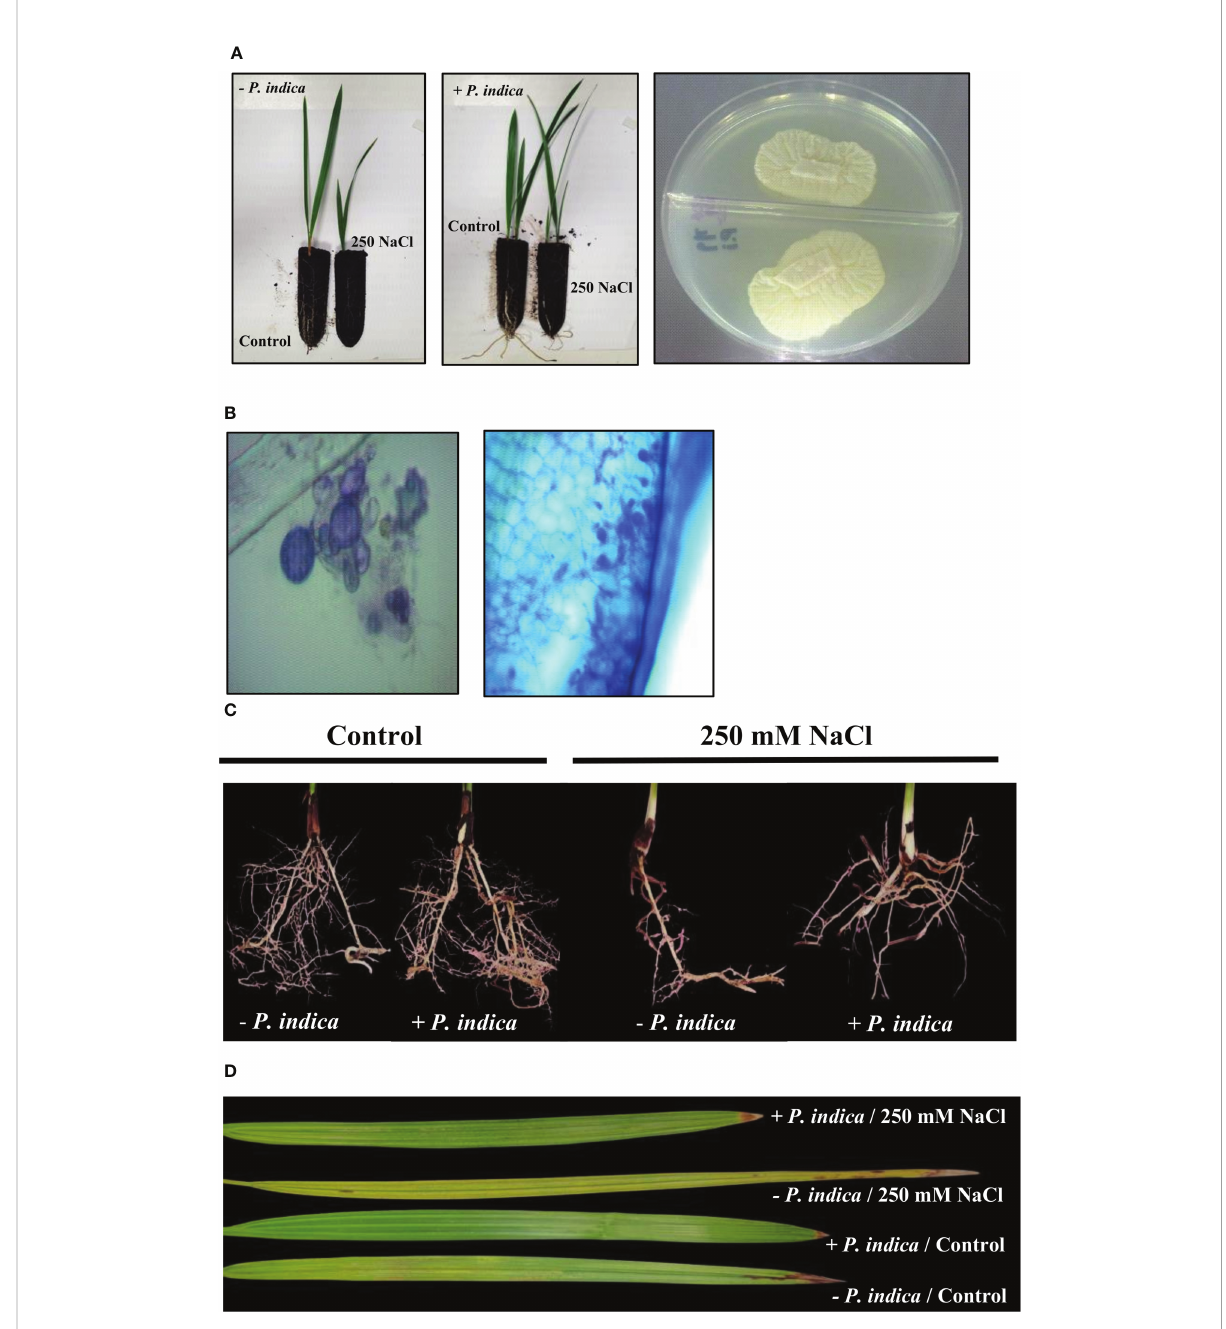
FIGURE 1 P. indica inoculation enhanced date palm seedlings root growth and biomass under control and salt stress conditions. (A) P. indica was axenically grown on PDA medium and used to inoculate date palm roots. (B) The colonized roots were stained and viewed under compound bright fi eld microscope to con fi rm the inoculation. (C) Lateral root density of inoculated and non-inoculated date palm seedlings grown in pots under control and salinity stress conditions. (D) Detached leaves variation for inoculated and non-inoculated date palm seedlings under control and salt stress